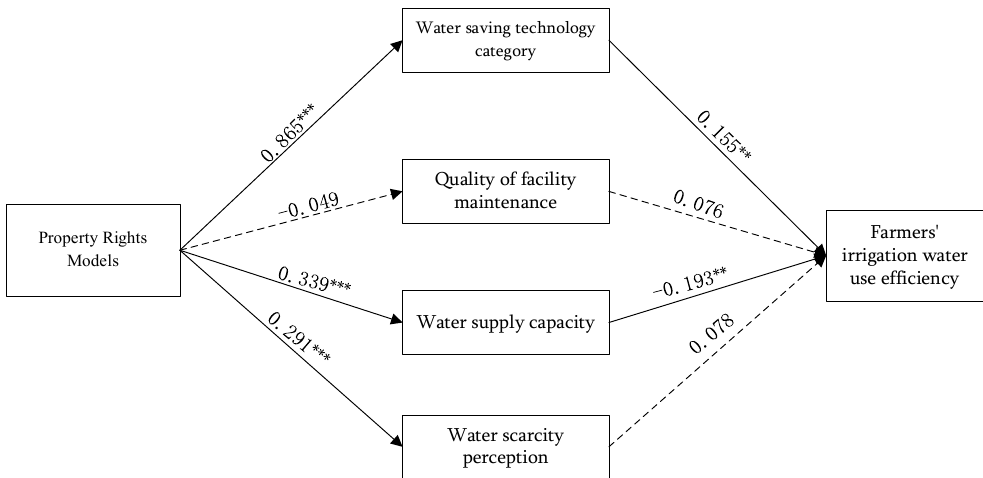
22 of 28 Table 11. Fitted indices of the path analysis model of the property rights development pattern af- fecting irrigation efficiency. Evaluation Indicators